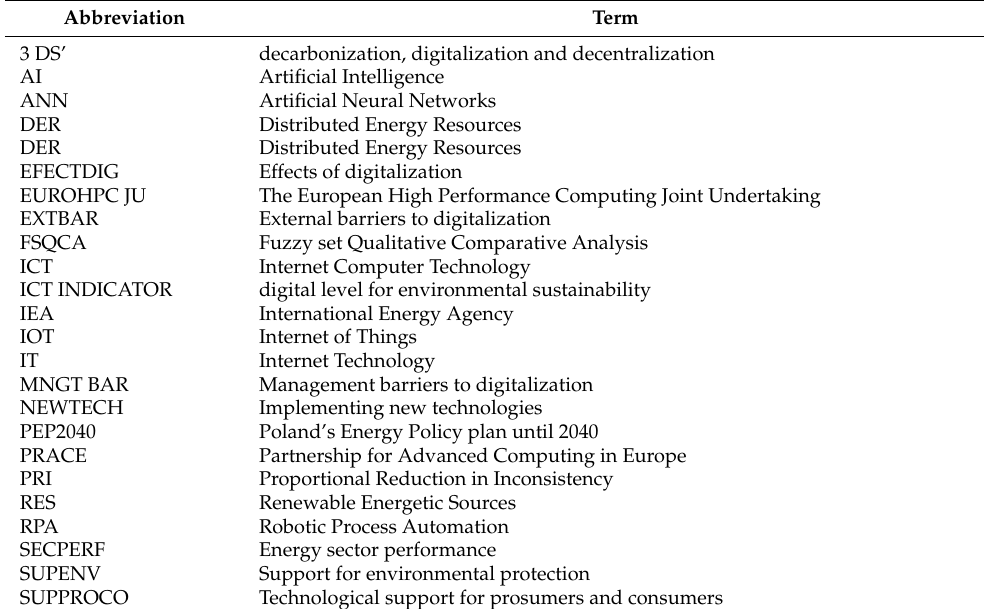
Table A1. Terminology abbreviations used in the